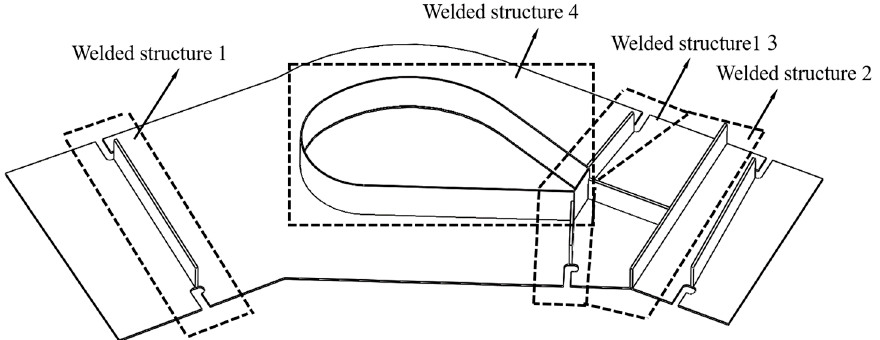
Figure 6. A ship medium assembly.